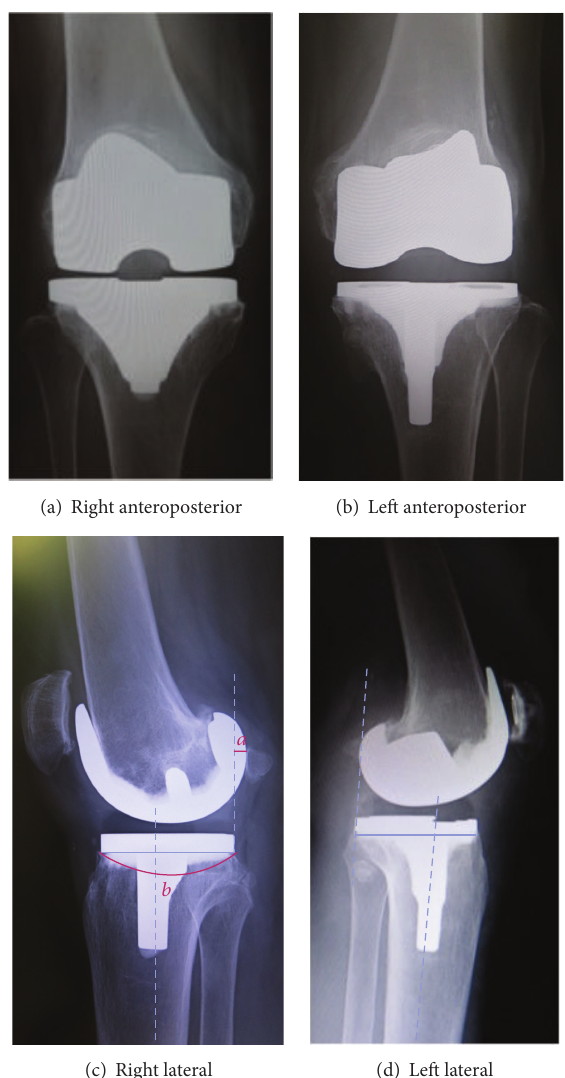
Figure 2: Postoperative